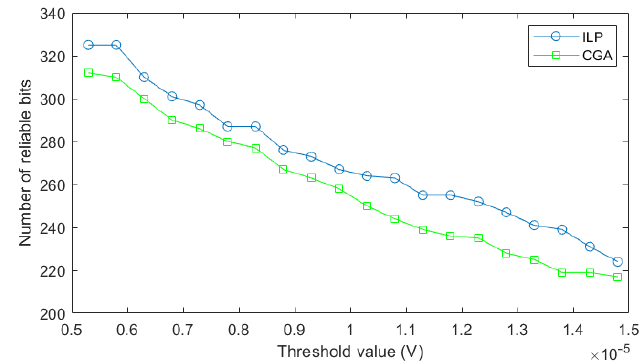
Figure 7. Reliable bits generated by ILP and CGA from SCN-PUF.